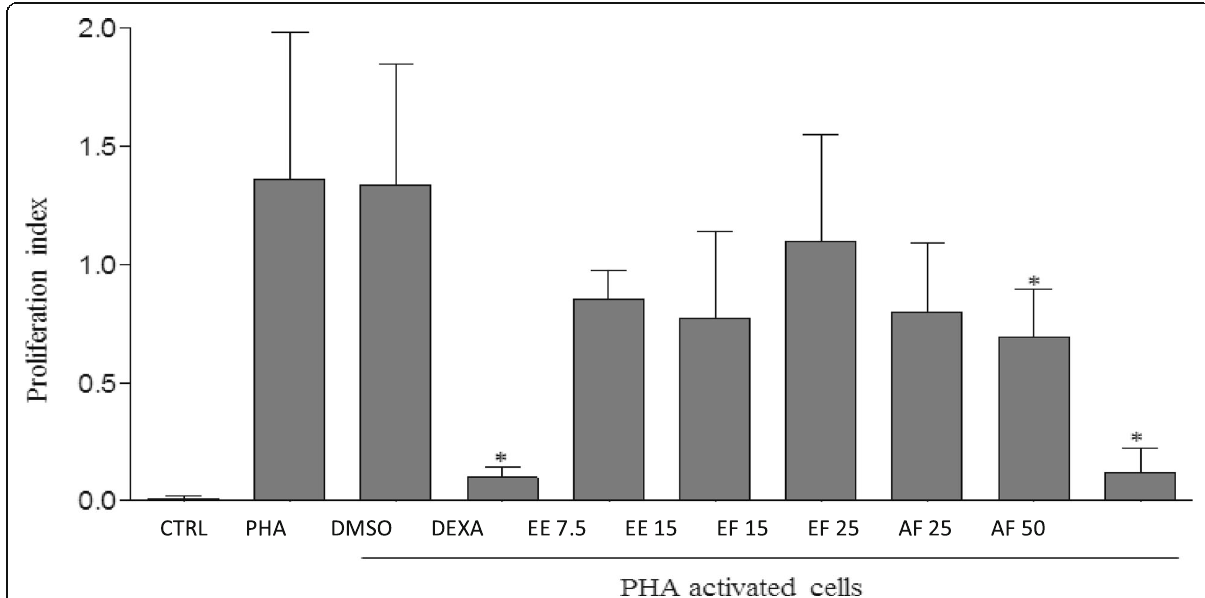
Fig. 3 Influence of EE extract and EF and AF fractions on the proliferation of activated lymphocytes. VPD 450-labeled human lymphocytes (5 × 10 5 cells) were cultured in the presence of medium, dexamethasone (DEXA, 8 μ g/mL) or different concentrations of EE (7.5 and 15 μ g/mL), EF (15.0 and 25 μ g/mL), AF (25.0 and 50.0 μ g/mL), and activated with PHA (5 μ g/mL) for 5 days. The lymphocyte proliferation was analyzed using flow cytometry. The results are expressed as the mean ± SD of the proliferation index of human lymphocytes ( n = 6). The ANOVA statistical method was used, followed by Tukey ’ s post hoc. * means significant difference ( p < 0.05)